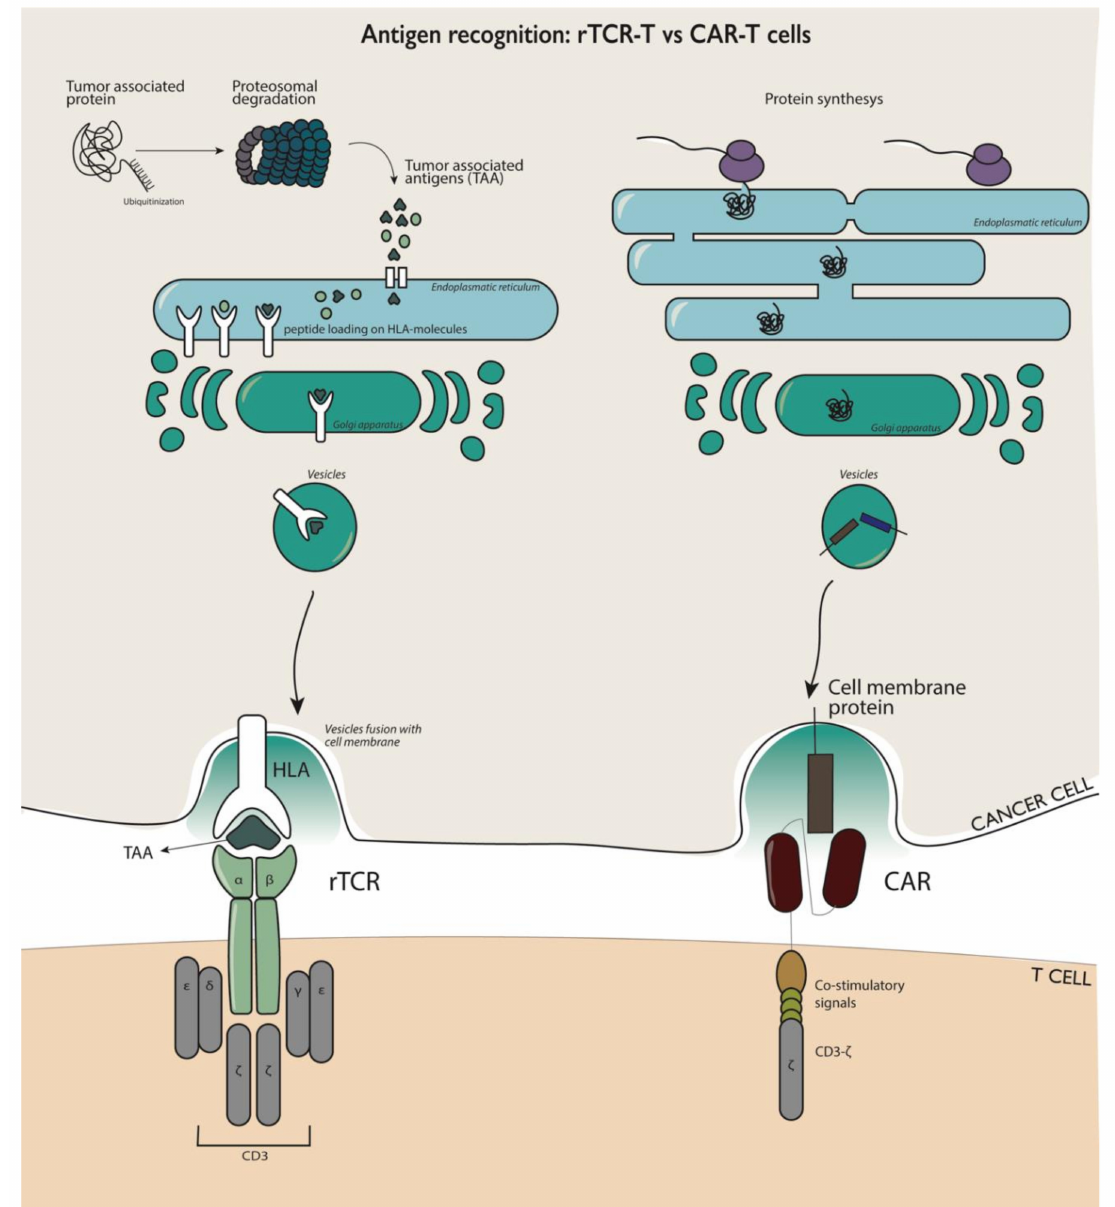
Figure 1. Di ff erences in the mode of action of antigen recognition and activation of rTCR-T cells (on the left) and CAR-T cells (on the right). rTCR cells can recognize the presented peptide from both intracellular and extracellular proteins that are proteolytically processed and presented through human leukocyte antigen (HLA) molecules. CAR-T cells can solely recognize extracellular membrane